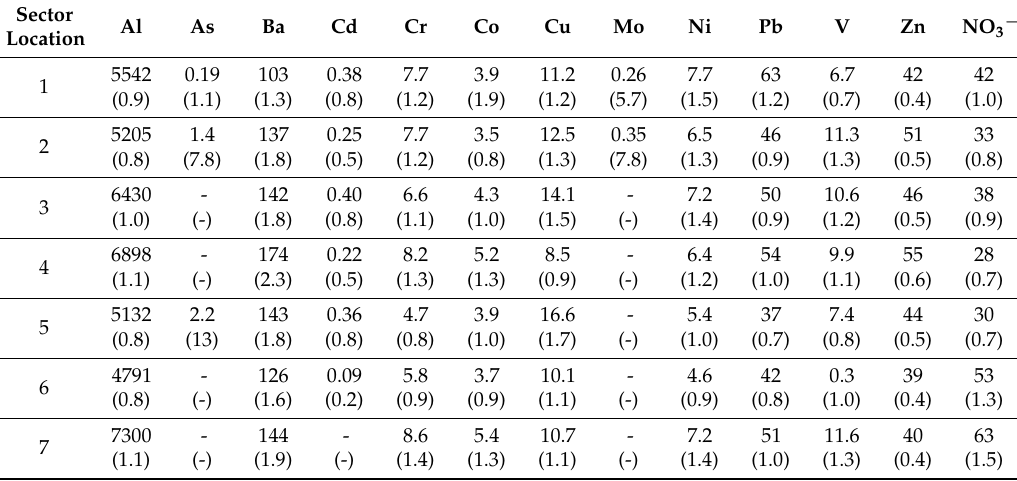
Table 4. Data for metals and NO 3 − concentrations in S